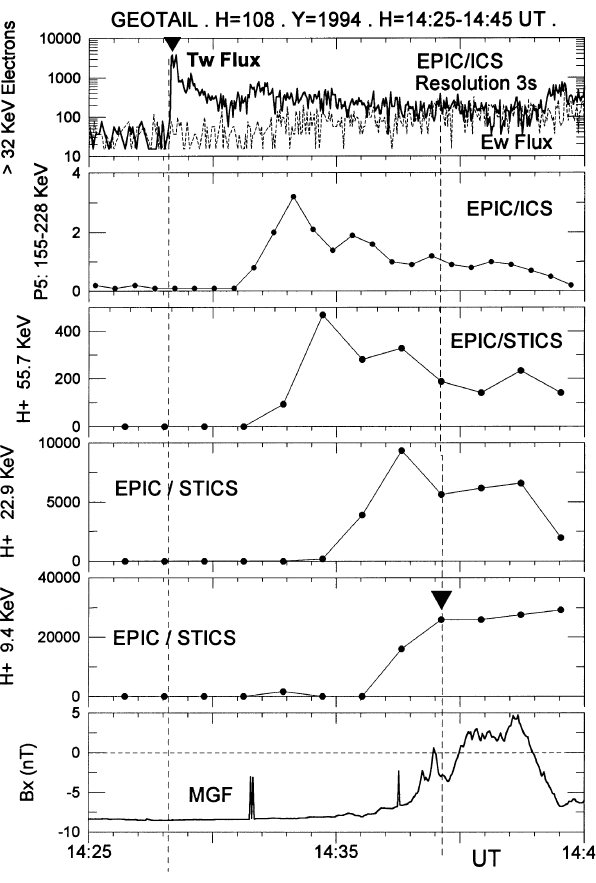
Fig. 9. As the GEOTAIL spacecraft enters the plasma sheet (see the B magnetic field component at the bottom panel ), it detects a x systematic displacement of peak fluxes. First appear the tailward- streaming >32-keV electrons, then arrive the fastest protons (155– 228 keV, second panel ) and progressively lower energy protons layers are encountered with mean energies 55.7, 22.9, and 9.4 keV, corresponding to the third, fourth, and fifth panels